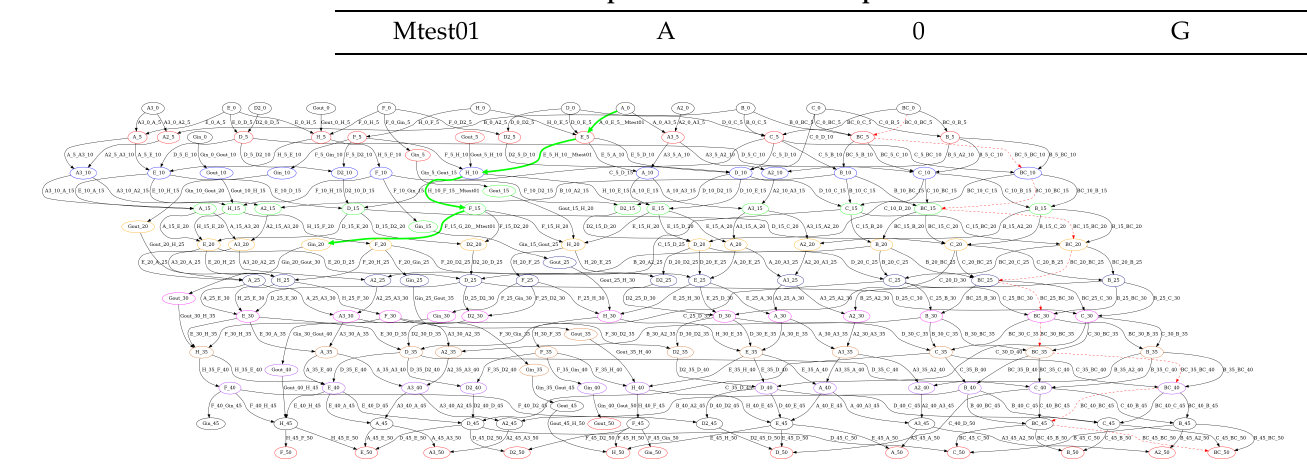
Figure 8. Case 1: Train schedule.